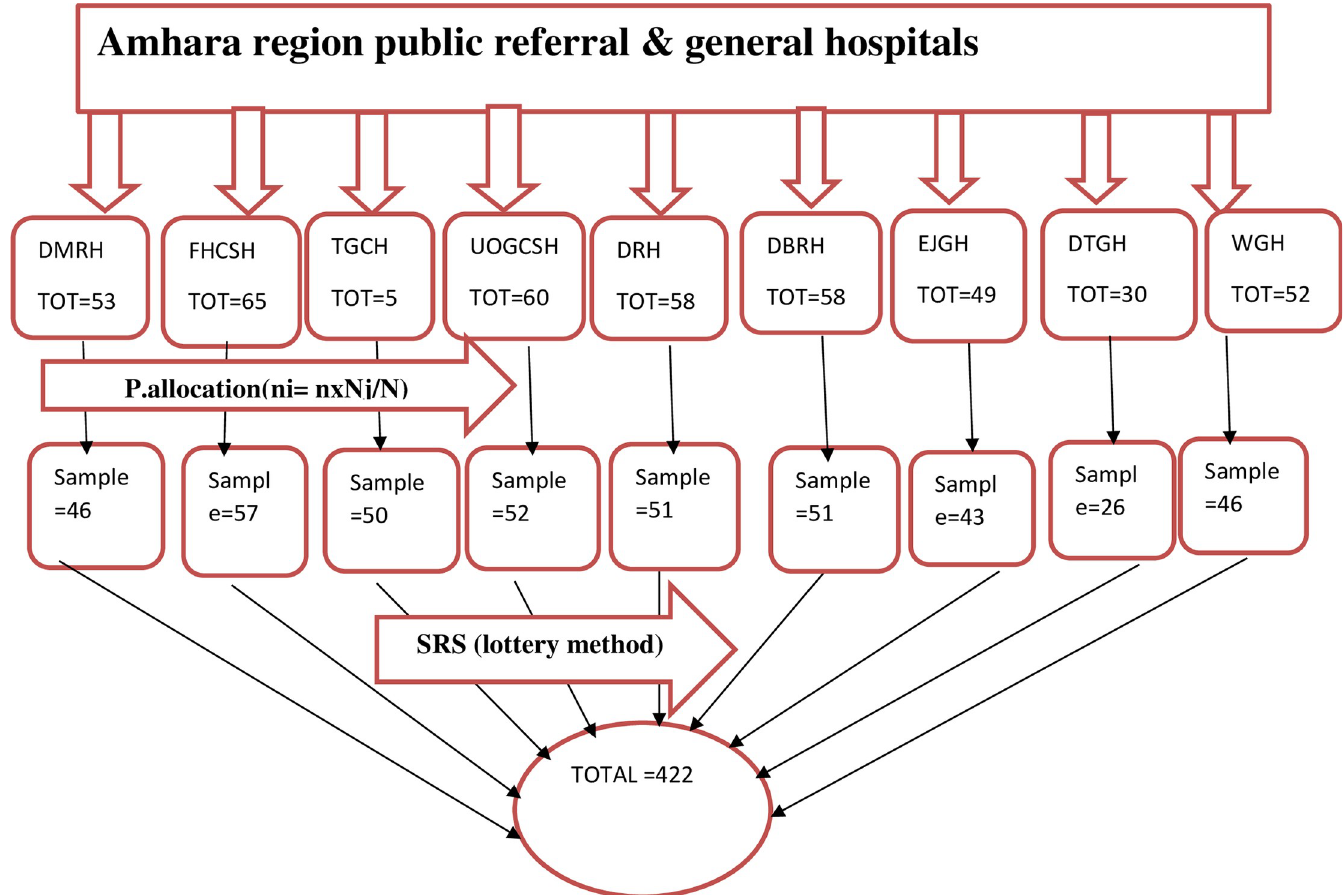
Fig 1. Sampling technique to select study participants among ICU nurses in public referral and general hospitals of Amhara Region, Ethiopia, 2020.